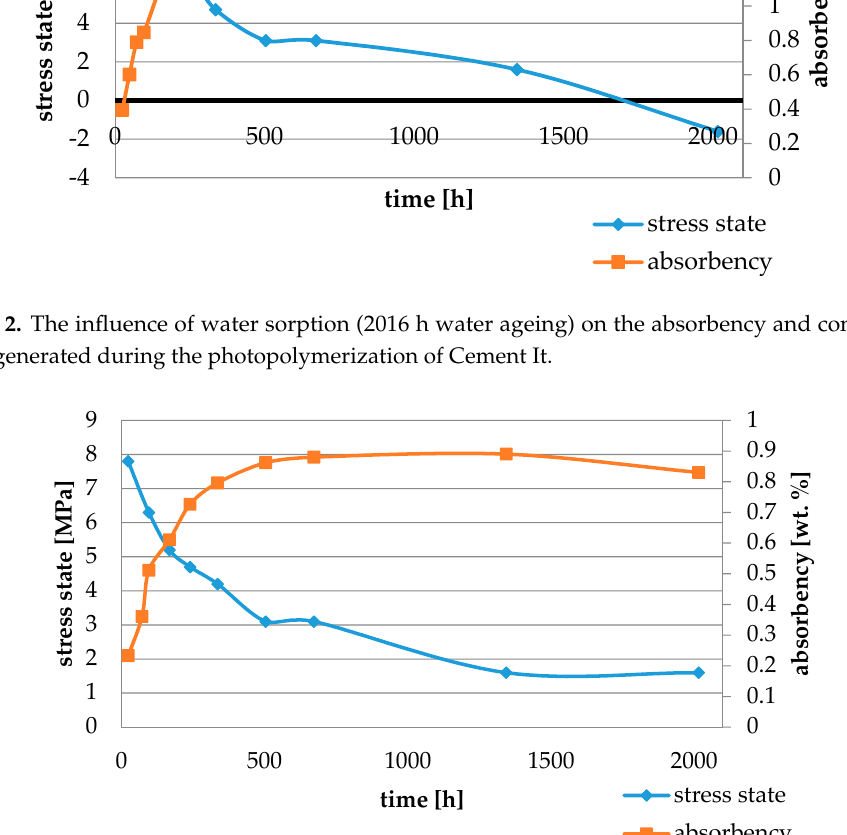
Figure 4. The influence of water sorption (2016 h water ageing) on the absorbency and contraction stress generated during the photopolymerization of Variolink Esthetic DC.